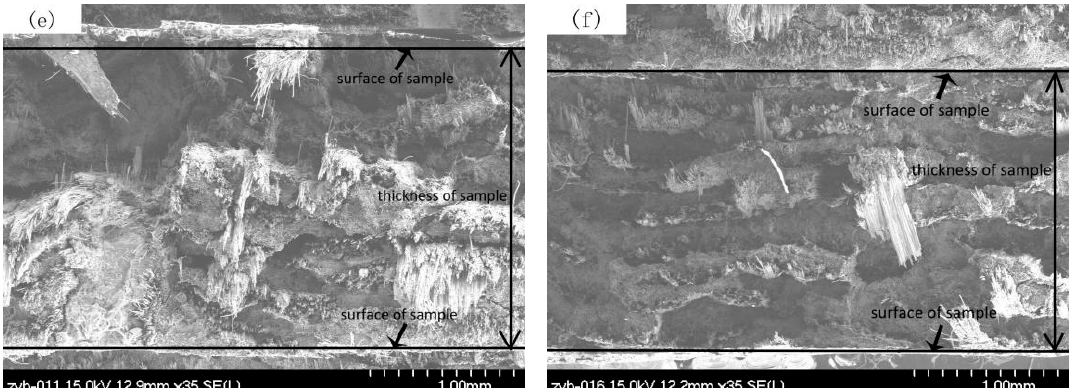
Figure 9. SEM images of the fracture surface of Cf/Al composites ( a )–( b ) with ϕ 0.3 mm z-pin, ( c )–( d ) with ϕ 0.6 mm z-pin, and ( e ) with ϕ 0.9 mm z-pin, ( f ) without z-pin.